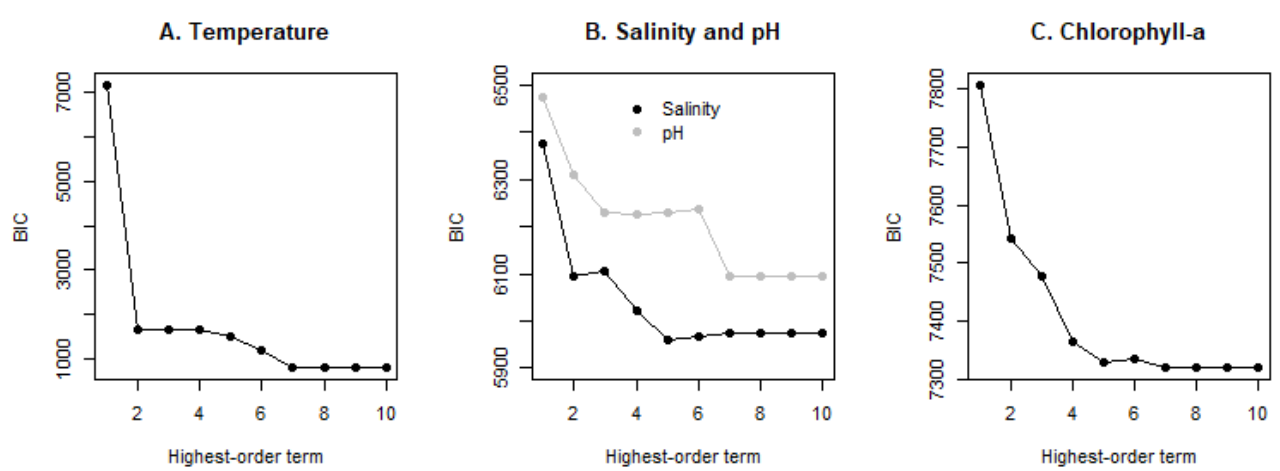
Figure A1. BIC of model variants with increasing number of higher-order terms for “week”. All models include first-order terms for “week” and “depth” and the first-order interaction term “week:depth”.